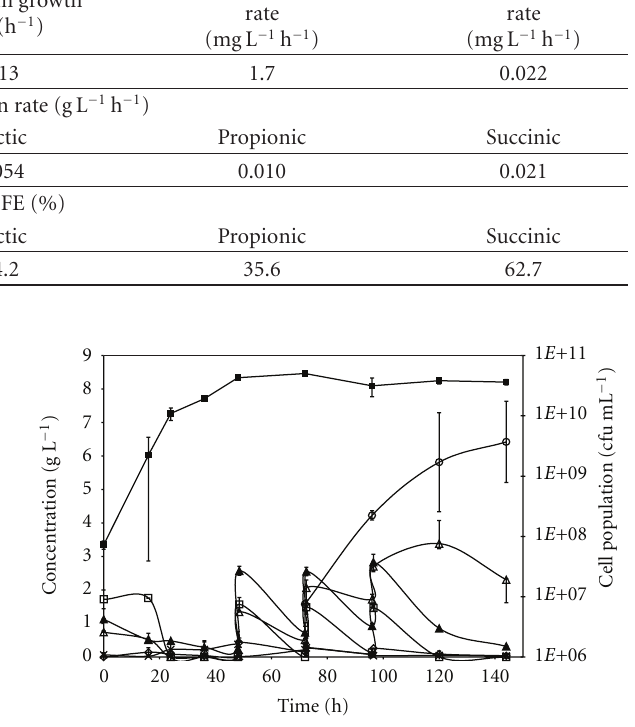
Figure 2: Acid utilization and growth of Ralstonia eutropha with 24 h interval additions of ARF. The values for cell count ( (cid:2) ), acetic acid utilization ( (cid:3) ), butyric acid utilization ( ♦ ), lactic acid utilization ( (cid:5) ), propionic acid utilization ( (cid:6) ), succinic acid utilization ( × ), and PHA concentration (O) are indicated. Values are the means of two replications with standard deviation showed by error